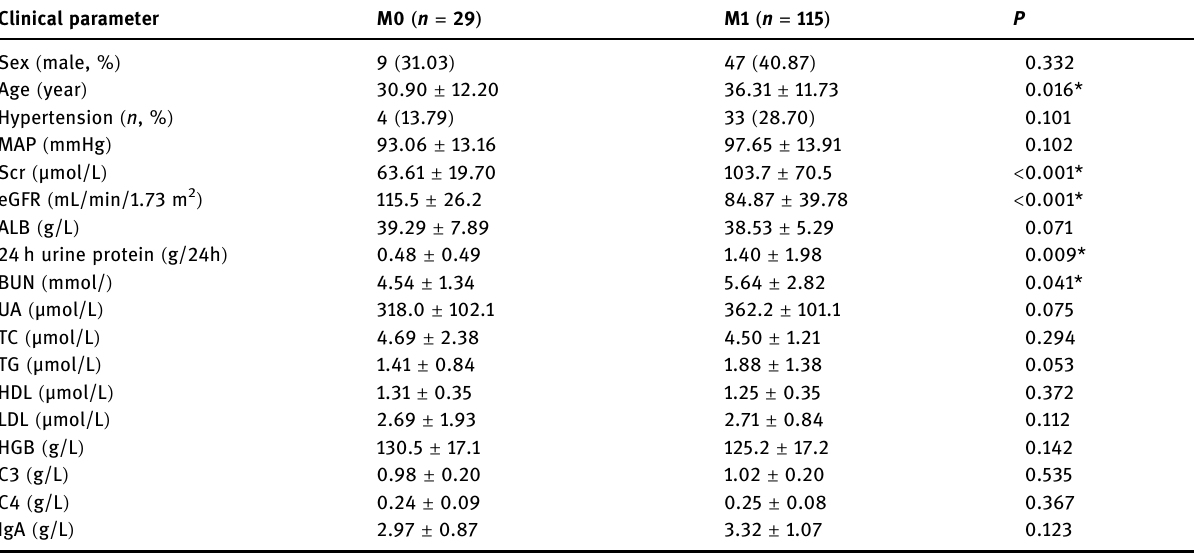
Table A1: Relationship of M score with clinical parameters of patients with IgAN Clinical